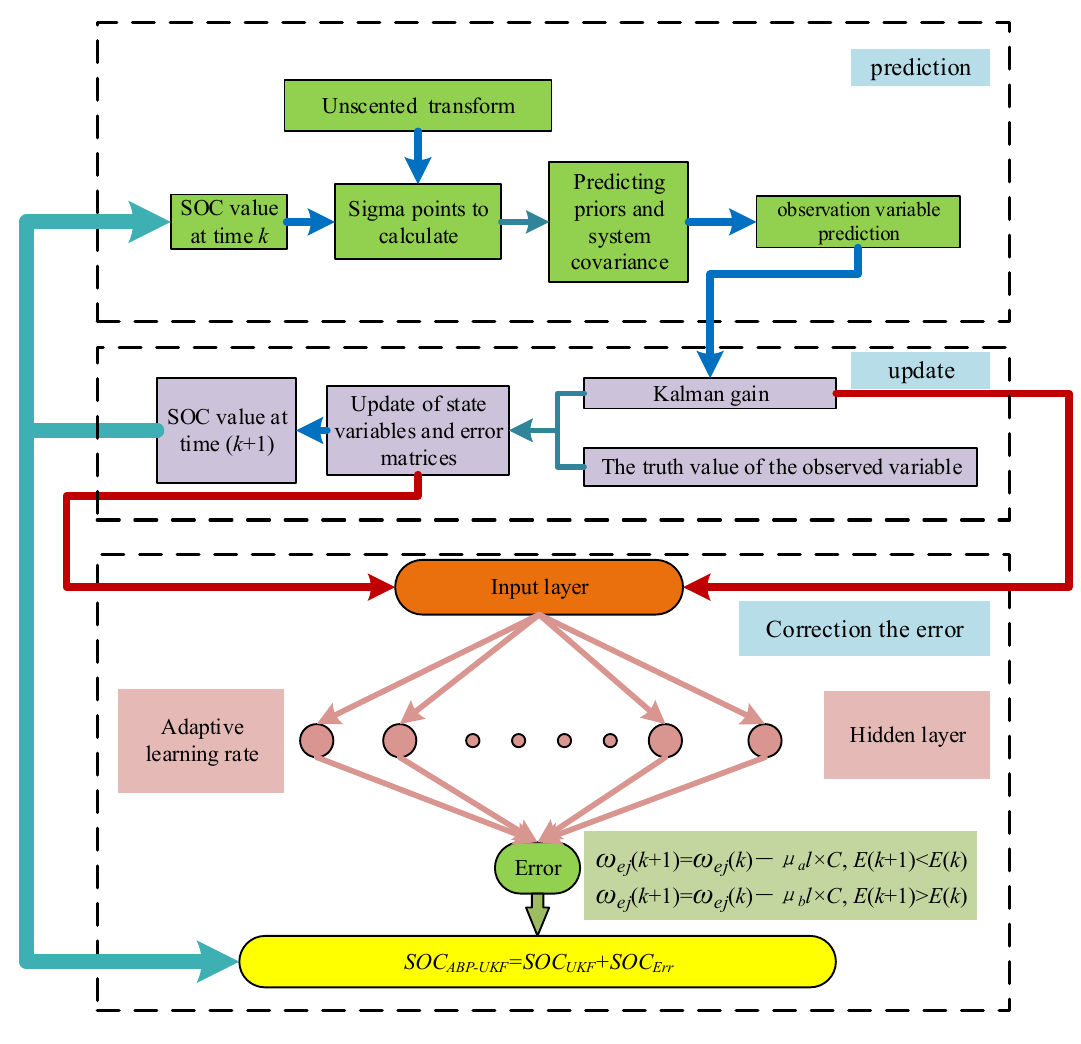
Figure 4. Block diagram of the ABP-UKF algorithm.